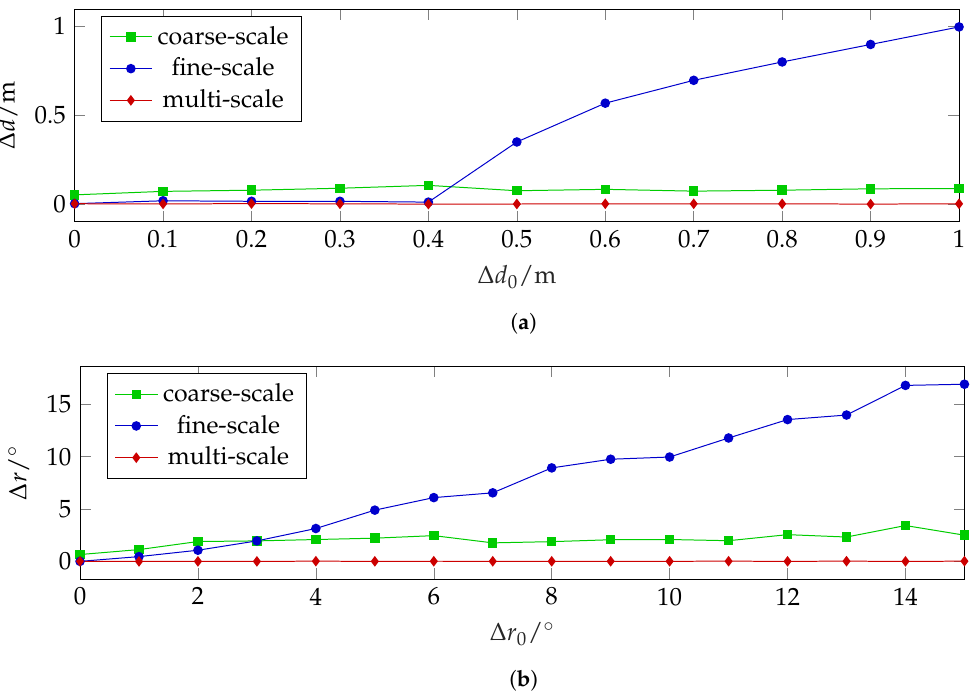
Figure 5. Single-scale vs. multi-scale calibration. ( a ) shows the translation error after performing the calibration depending on the initial translation error. ( b ) shows the rotation error after performing the calibration depending on the initial rotation error. The coarse-scale approach is more robust to large initial calibration errors than the fine-scale approach. However, the fine-scale approach is more accurate for small initial calibration errors. The multi-scale approach combines the advantages of both single-scale